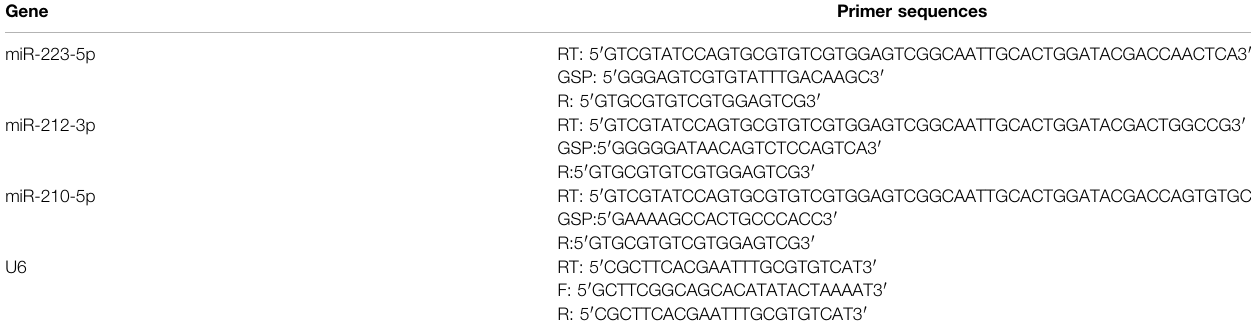
TABLE 1 | miRNA stem-loop primers used for qRT-PCR. Gene Primer sequences